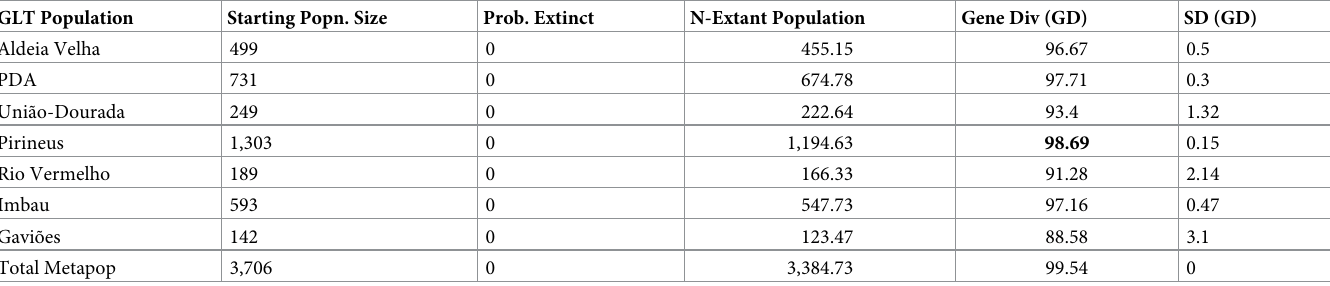
Results from VORTEX modeling of GLT populations in seven MUs and for the total metapopulation. Prob Extinct is probability of extinction calculated as the proportion of iterations that went extinct, N-Extant Population is the mean size of modeled populations surviving to 100 yrs, Gene Div is mean percentage of expected heterozygosity remaining in the extant population with standard deviation (SD) across iterations. PDA is Poc¸o das Antas Biological